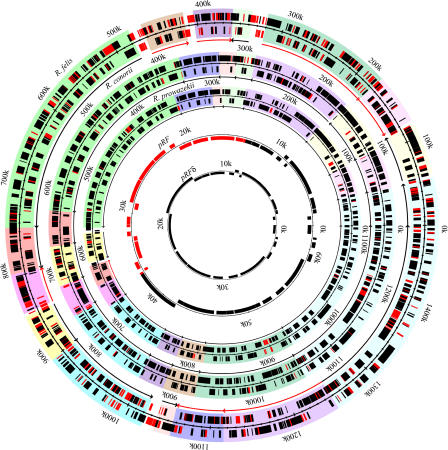
Circular Representation of R. felis, R. conorii, and R. prowazekii GenomesThe three outer circles represent the chromosomes of R. felis, R. conorii, and R. prowazekii, respectively, with specific ORFs colored in red and nonspecific ORFs colored in black. Colinear genome fragments are highlighted by a shared background color, with their relative orientations indicated by arrows. The two inner circles represent two R. felis plasmids (pRF and pRFδ), with ORFs in the region unique to pRF colored in red.